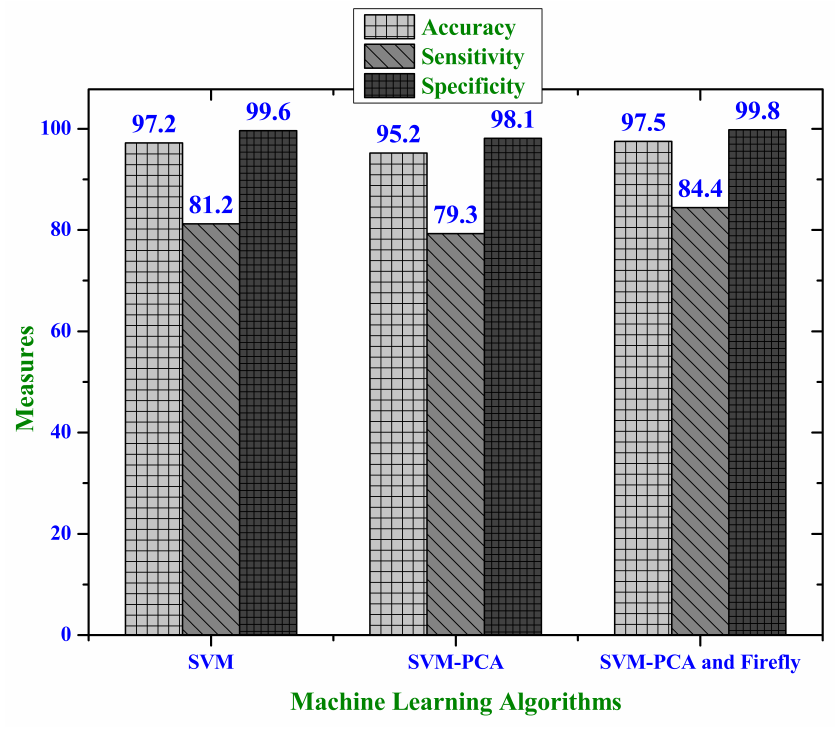
Figure 7. Performance evaluation of SVM classifier.